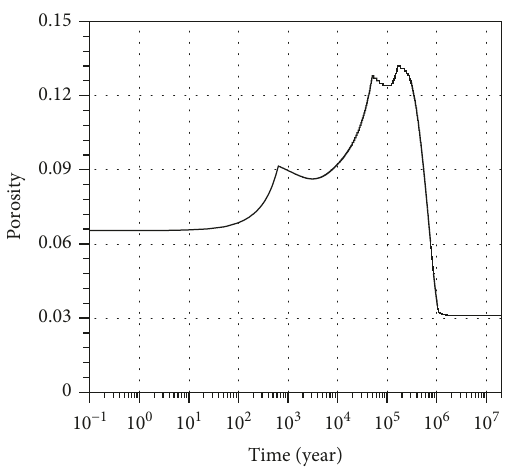
Figure 6: Variation of simulated porosity of sandstone versus time in the Base